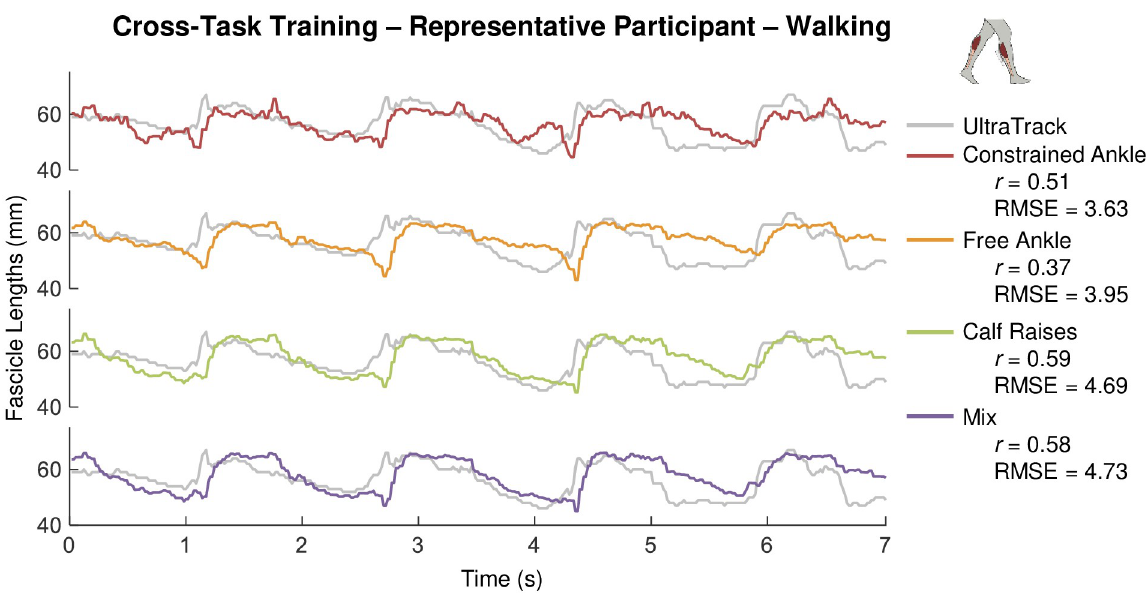
Fig 5. Muscle fascicle length versus time from optimized ML algorithm with cross-task training in the walking task. Subplots show raw output of muscle fascicle length (mm) versus time (seconds) estimated using B-mode ultrasound images fed through a support vector machine (SVM) machine-learning (ML) model with optimized hyperparameters for a representative participant X during several cycles of a given ankle movement task (e.g., constrained ankle = red (top); mix = purple (bottom)). In each case, the SVM ML output was generated following a training procedure using image data from each of the other tasks (e.g., constrained ankle = red, mix = purple) and then used to measure muscle fascicle length during walking in the test participant X (i.e., cross-task training). Muscle fascicle lengths derived from inputting the same B-mode images into UltraTrack (UT) software (gray) are included as ‘ground-truth’ to give context regarding correlation and RMSE across tasks.